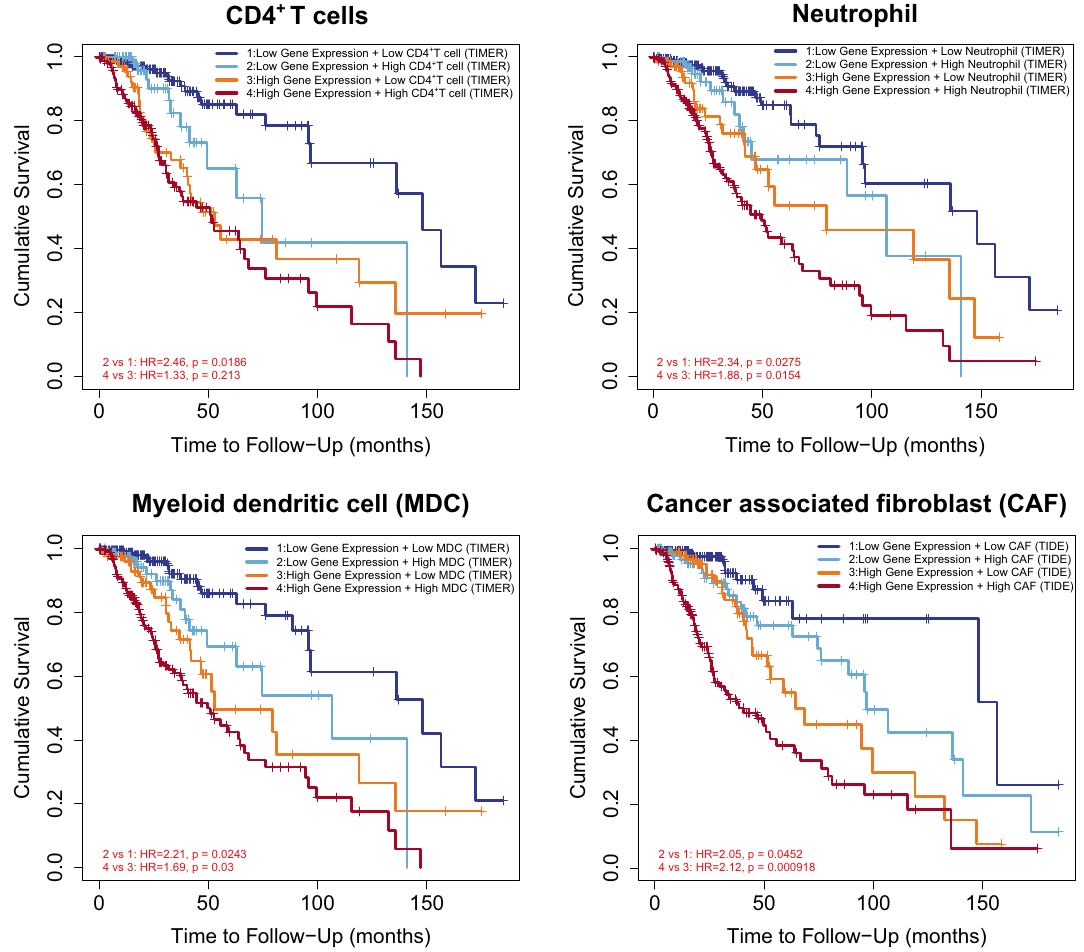
Figure 13. Effect of GPX7 expression and immune infiltration on TCGA-LGG patients overall survival (OS). Kaplan–Meier plot displaying differences in OS among patients stratified by both the predicted infiltration level of immune cells (CD4 + T cells, neutrophil, myeloid dendritic cell and cancer-associated fibroblast) and GPX7 expression level in LGG. High and low immune infiltration cutoffs were determined based on the infiltration score greater than or less than 0, while high and low GPX7 expression cutoffs were defined using the median. The prognostic signature built by the immune infiltration of CD4 + T cells, neutrophil, myeloid dendritic cell and GPX7 expression was profiled by TIMER algorithm, while the signature of cancer associated fibroblast and GPX7 expression was profiled by TIDE. P-values were calculated using the log-rank test and vertical hash marks indicate censored